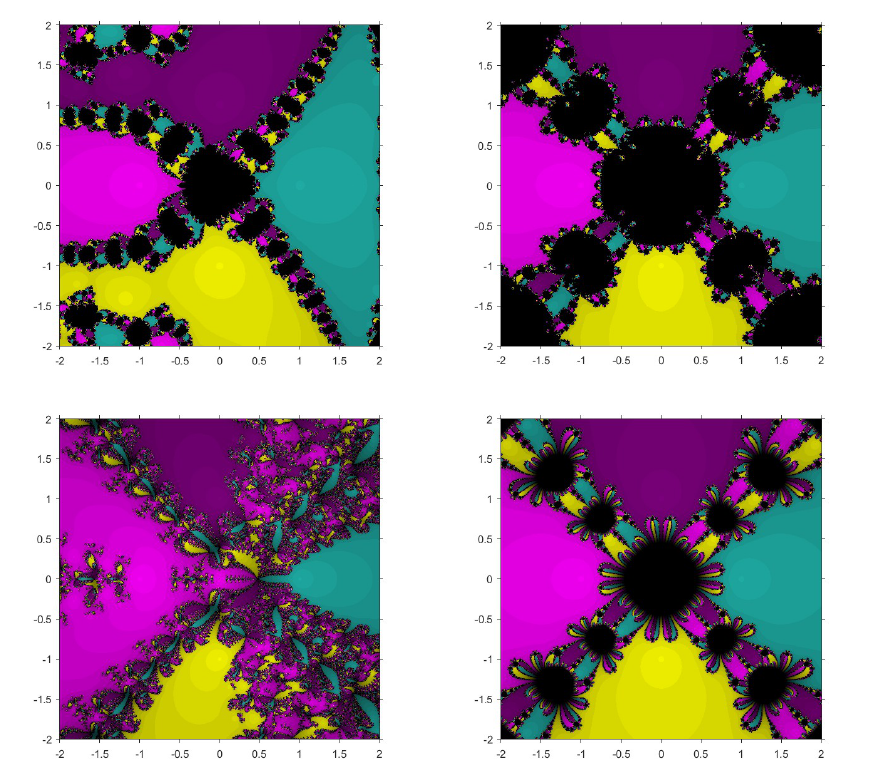
Figure 5. Basins of attraction for PM , SM , AM 1 , and CM , respectively, for p 3 ( z ) .